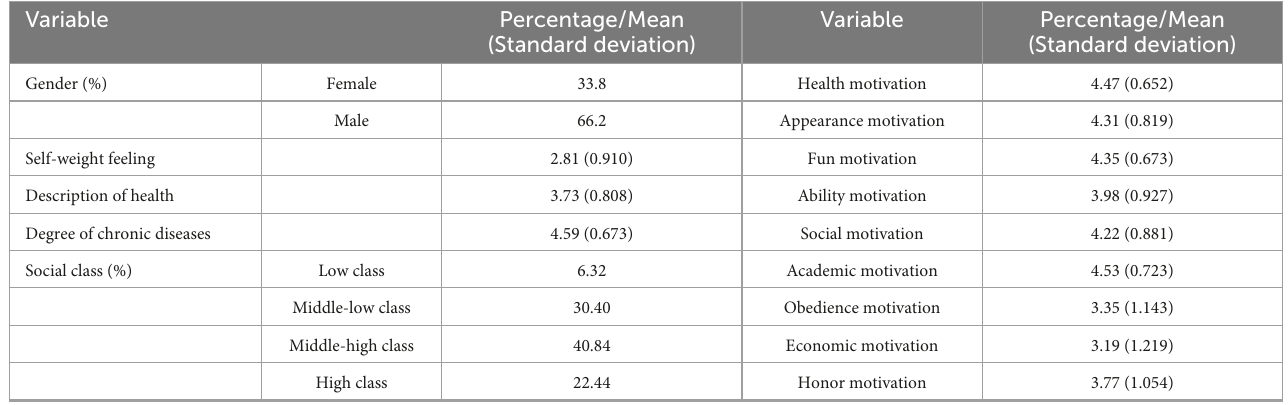
TABLE 1 Descriptive statistical results of sample characteristics ( N =